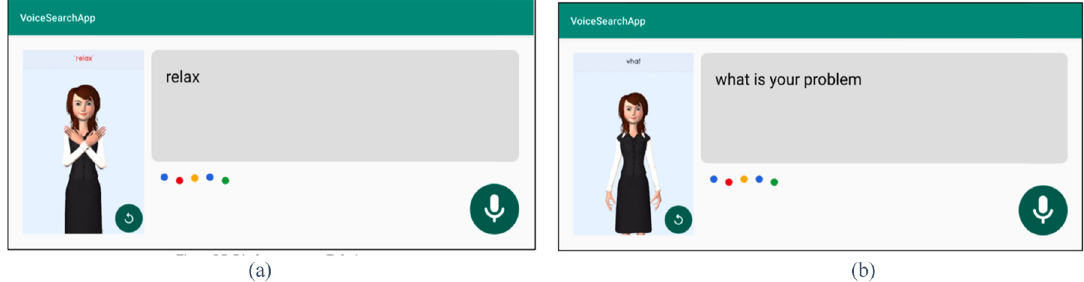
Figure 8: Translating the voice to word ( a ) and translating voice to a sentence language ( b )